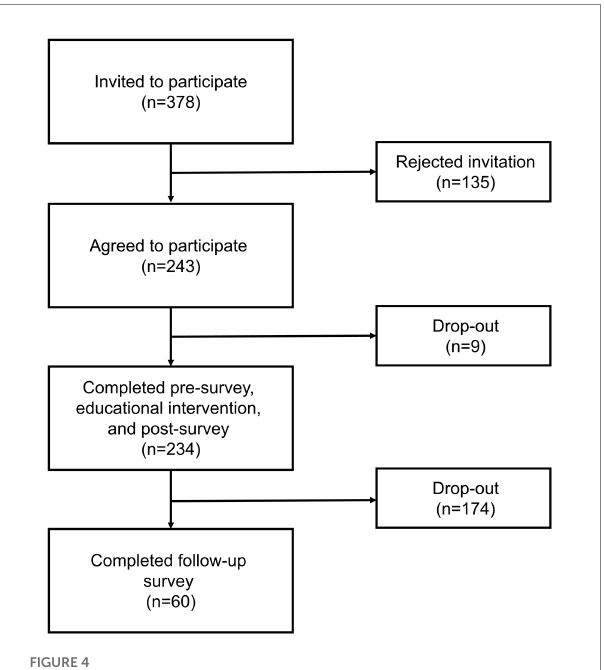
FIGURE 4 Flow diagram of response and completion